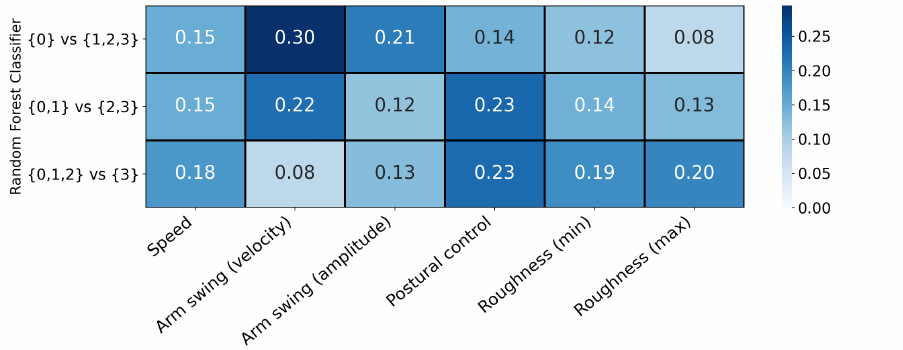
Figure 9. Feature importance of the three random forest classifiers contained within the ordinal classifier. The impurity-based (Gini) importance was calculated as the normalized total reduction of the Gini coefficient by the feature. Arm swing features were important to distinguish normal gait from Parkinsonian gait. Roughness of movement features were important to distinguish between different levels of Parkinsonian impairment.